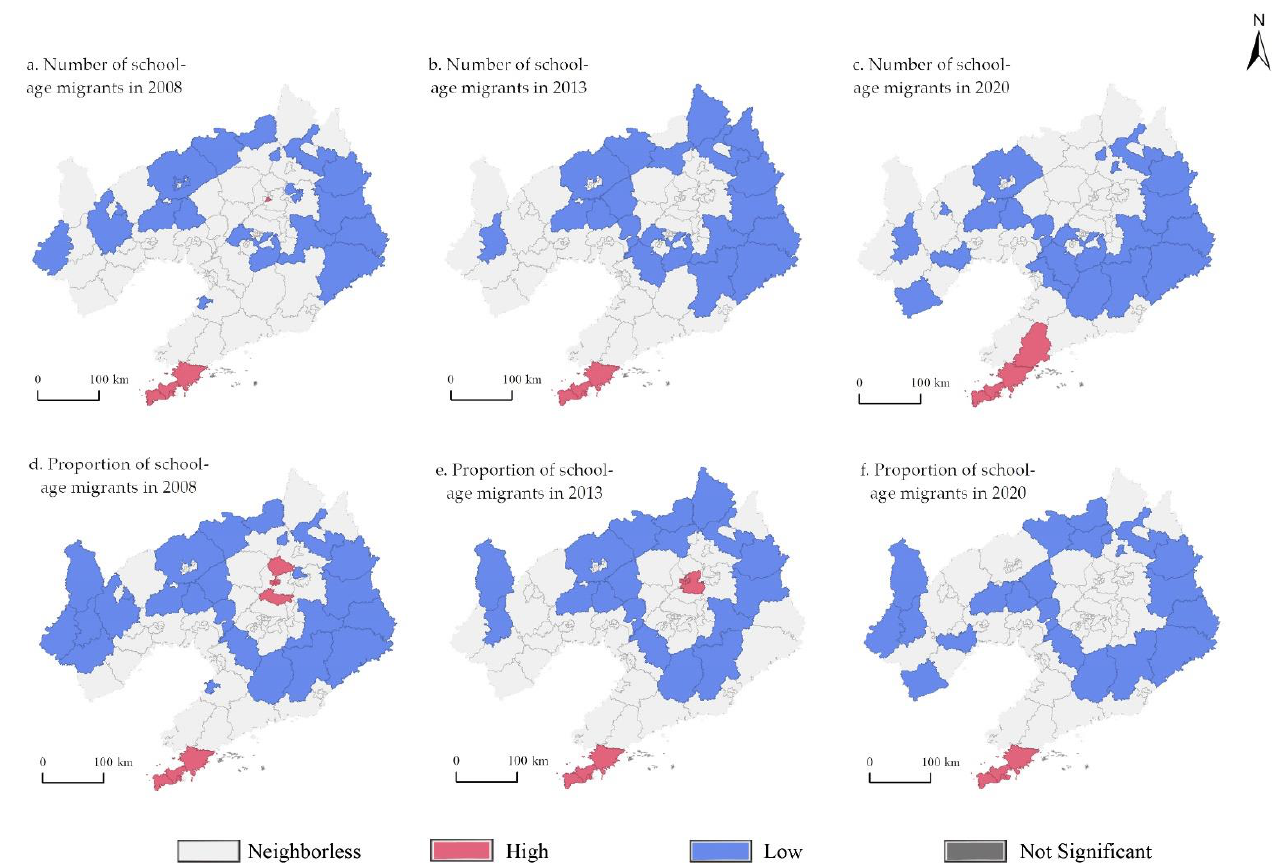
Figure 4. Spatial agglomeration of the school-age migrant population in Liaoning Province from 2008 to 2020: ( a – c ) number of school-age migrants and ( d – f ) proportion of school-age migrants.